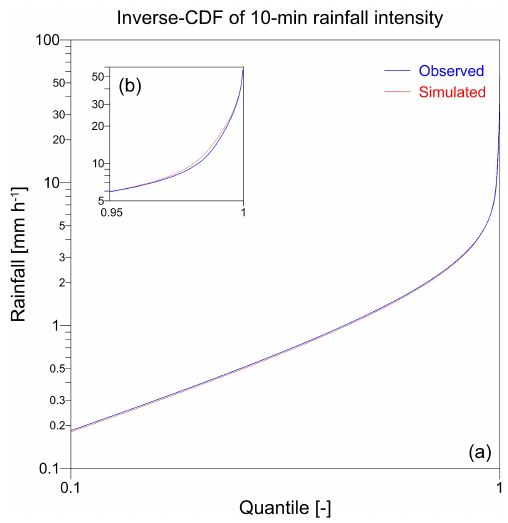
Figure 3. An inverse cumulative distribution function of the 10min mean areal rain intensity over the catchment (the 0.1–1 quantile range is presented in a and the 0.95–1 quantile range is zoomed in b ). The blue line represents 34 years of observed data (1981– 2014) and the red line represents the median of 30 realizations of 30 years. The simulated mean 5–95 quantile range of the rainfall intensity of the 30 realizations is also presented (shaded